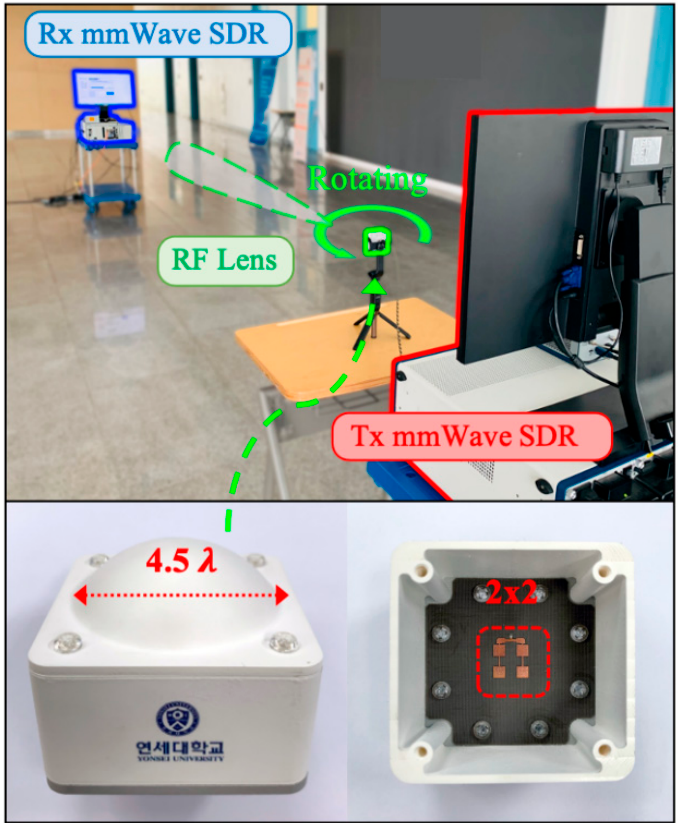
Figure 14. Indoor mmwave software-defined radio (SDR) testbed with a fabricated RF lens for beam squint [61].